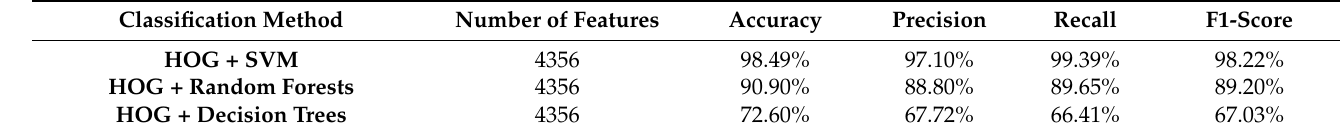
Table 4. Accuracy, Precision, Recall, and F1-scores using reduced HOG features.